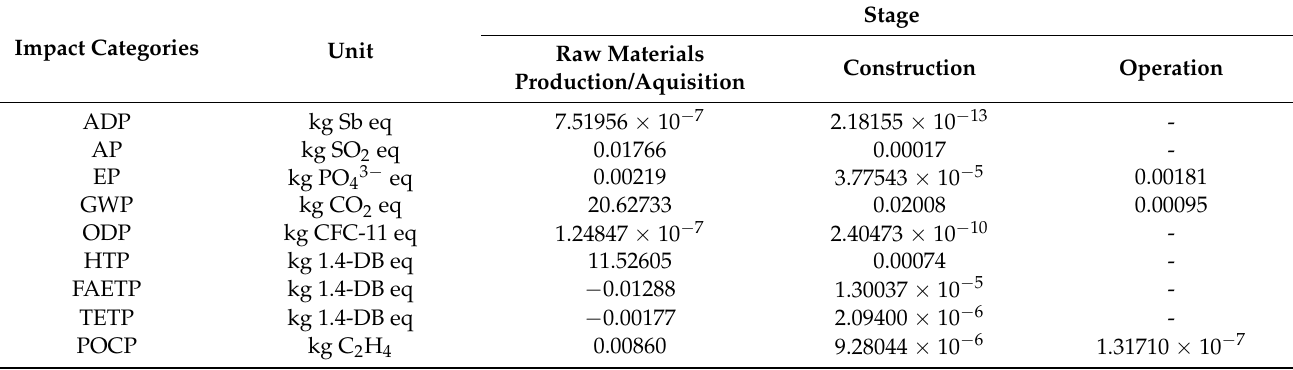
Table 3. Impact values of floating wetland during raw material acquisition, construction, and operational stages.